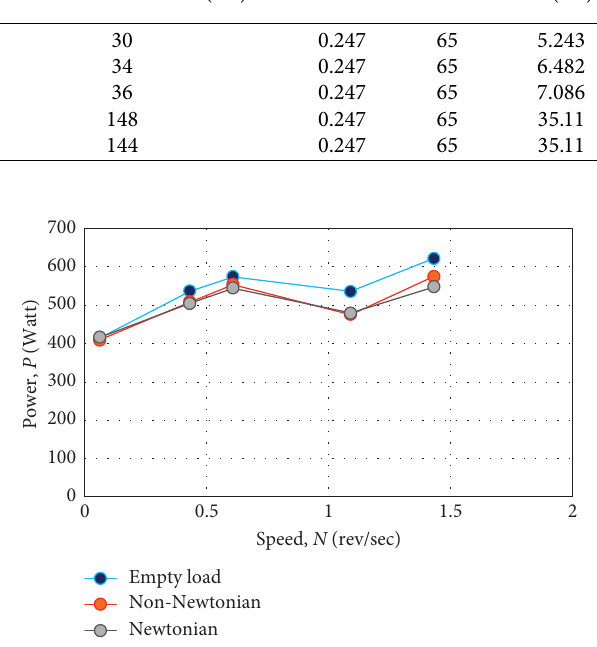
Figure 5: Power consumption for empty load, non-Newtonian fluid, and Newtonian fluid.